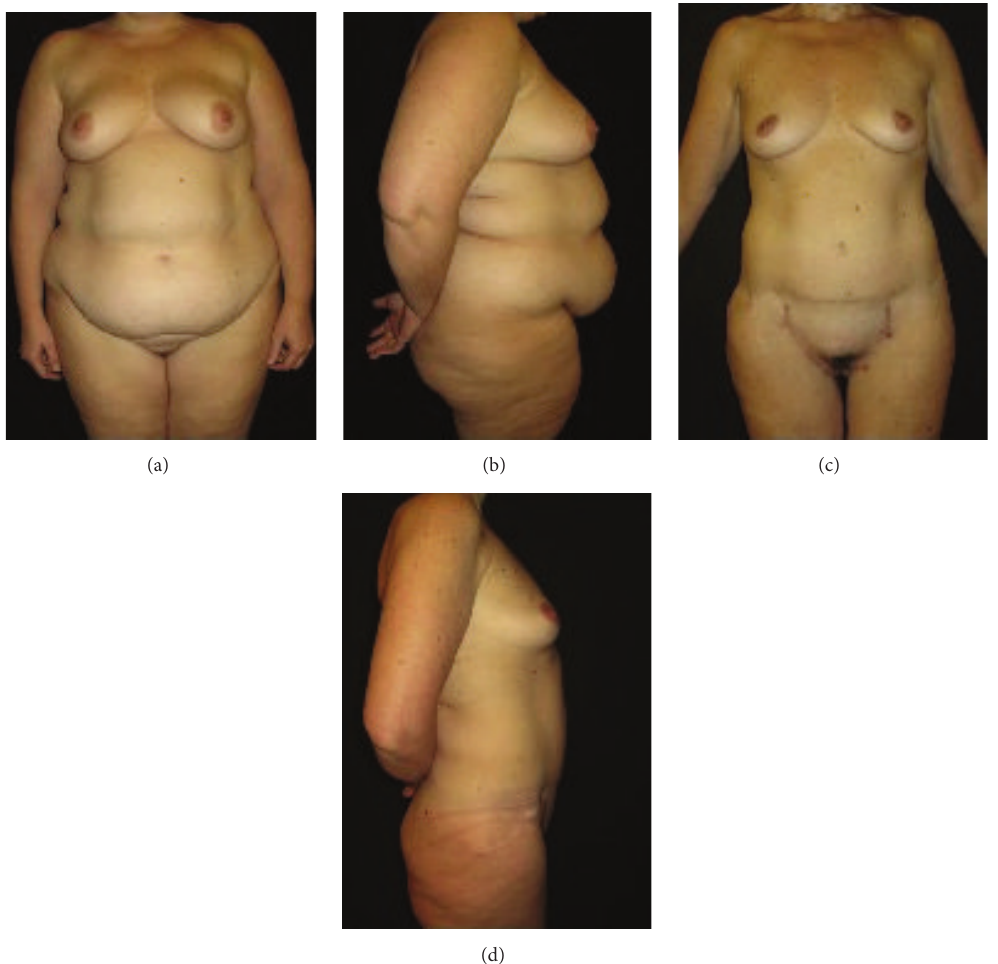
Figure 4: (a) Preoperative frontal view and (b) lateral view of a female patient (BMI = 50 kg/m 2 ; body weight = 135 kg). (c) Postoperative frontal view and (d) lateral view three years after surgery (body weight = 65